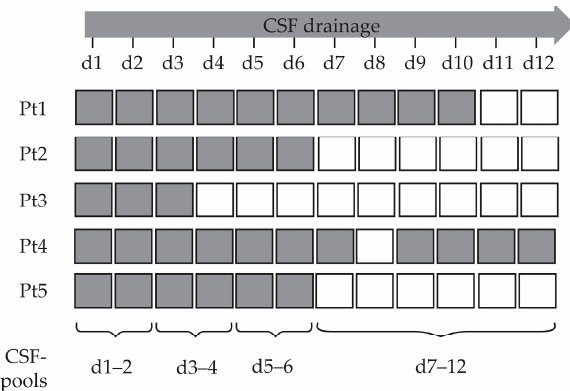
Figure 1. Collected individual cerebrospinal fluid (CSF) samples and the creation of consecutive CSF pools from severe traumatic brain injury patients. Individual CSF samples from five patients (Pt) were collected on indicated (grey shaded boxes) days (d) and combined into four consecutive CSF pools (d1–2, d3–4, d5–6 and d7–12), which were used for downstream analyses.